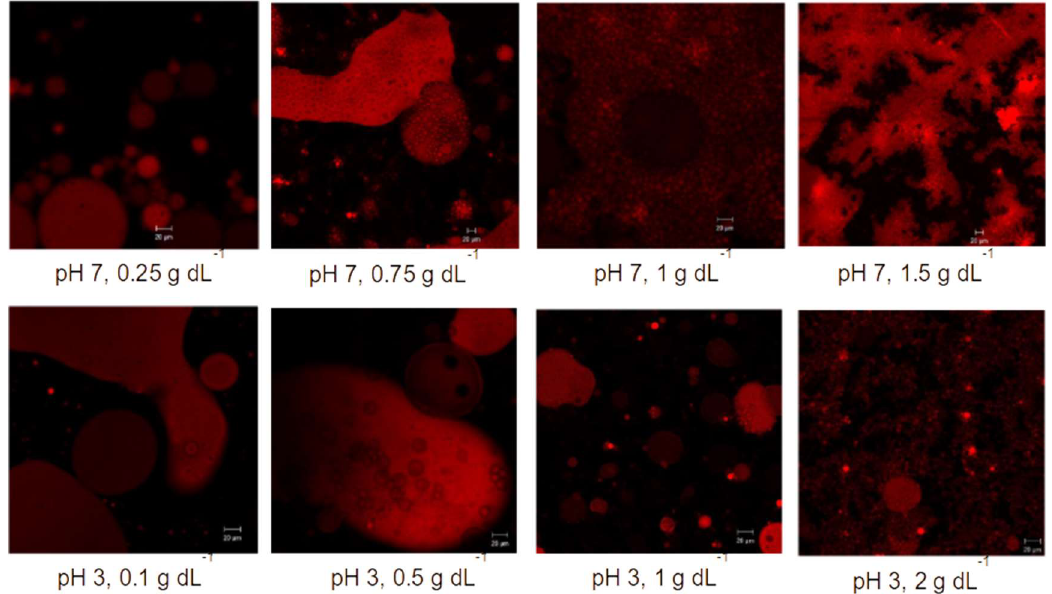
Figure 2. Confocal micrographs of emulsions prepared using bean extract at pH 7 and at pH 3. Nile red has been used as to stain the oil phase (here depicted in red).